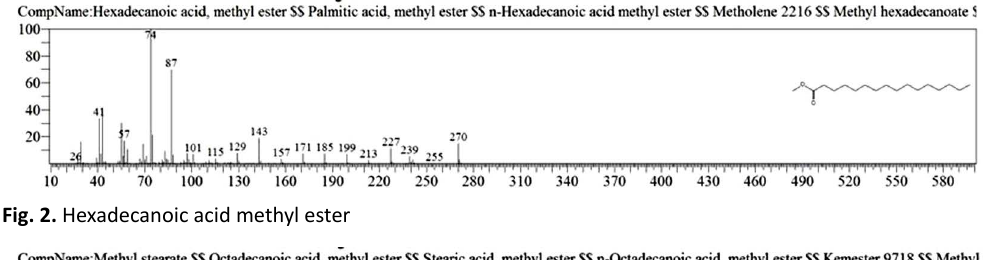
Fig. 2. Hexadecanoic acid methyl ester